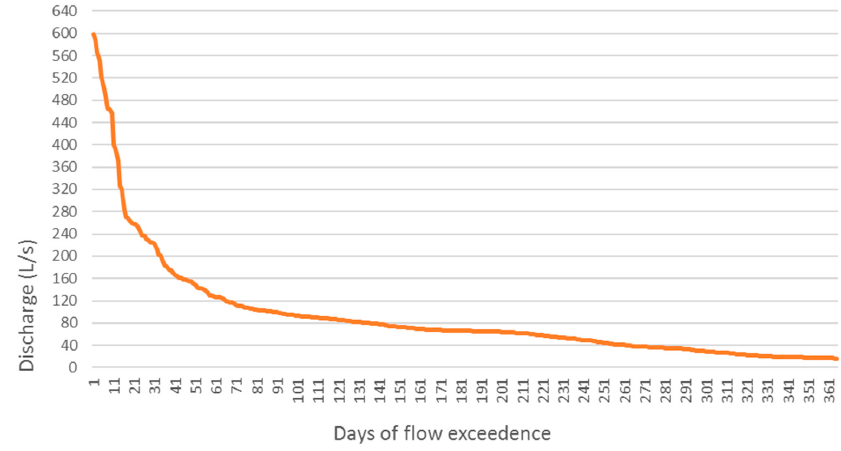
Figure 7. Calculated flow duration curve for the year 2015.